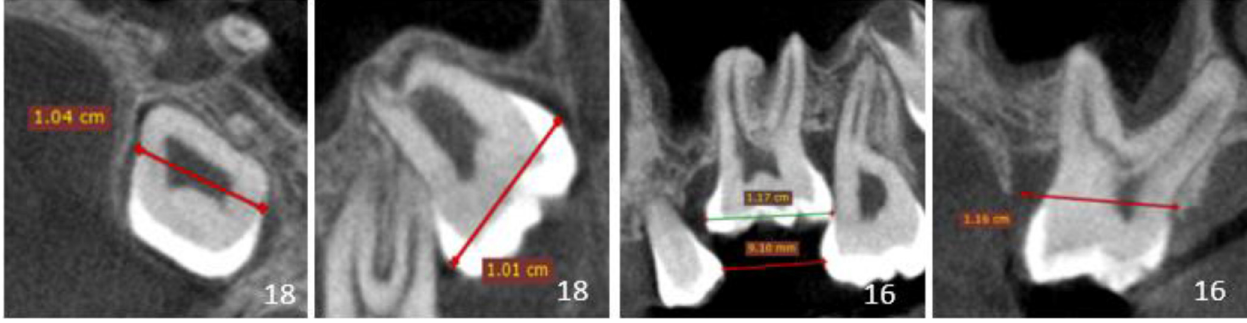
Fig. 2. Cone beam computed tomography sections and three dimensional analysis of teeth 16 and 18 showing the match between the dimension of the donor tooth and its future alveolar socket.